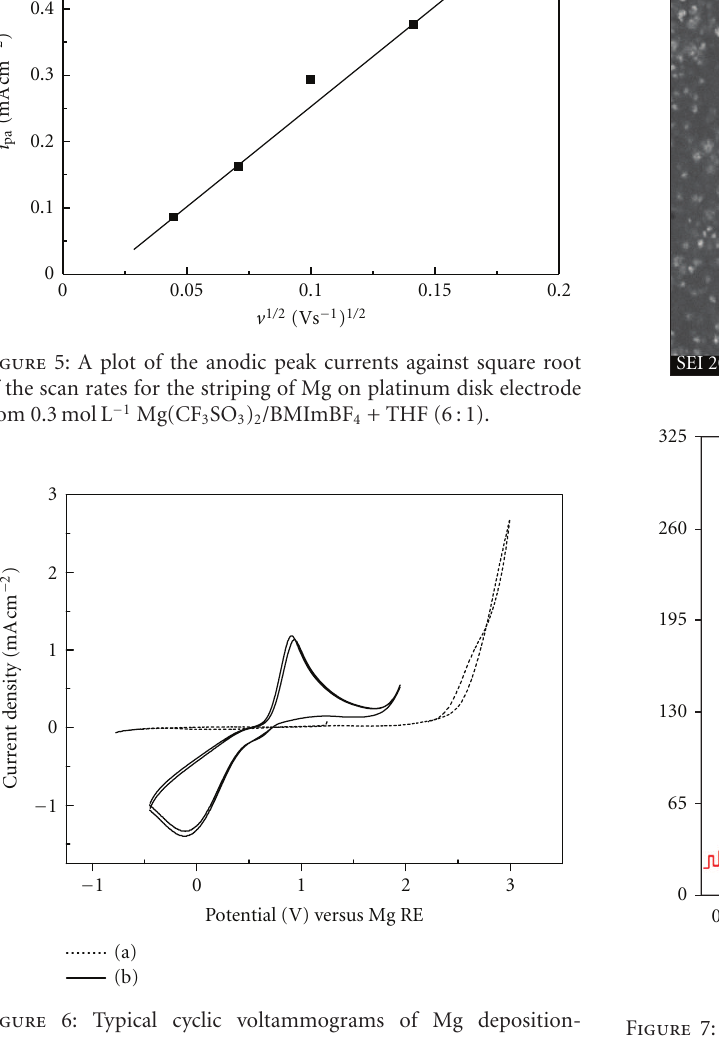
Figure 7: SEM image of magnesium deposit and corresponding EDS result on copper substrate from 0.3 molL − 1 Mg(CF 3 SO 3 ) 2 / BMImBF 4 + THF (3:1) solution. The charge amount is 1.8Ccm − 2